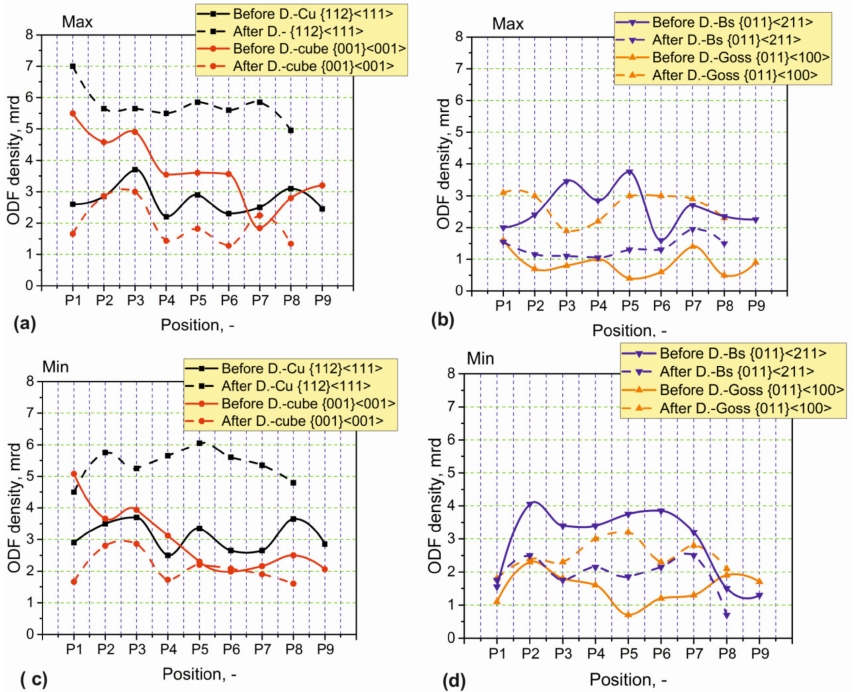
Figure 11. Change in principal components cube , Goss , and Bs before and after the first drawing step at ( a , b ) max and ( c , d ) min side of the tube. The measuring points are P1 to P9, as sketched in Figure 10.